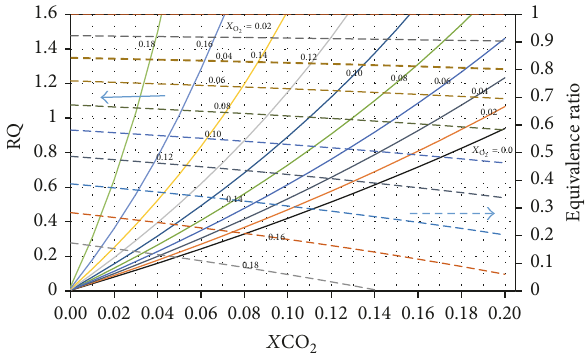
Figure 6: Variation of RQ and equivalence ratio { called OEF in biology } with respect to dry carbon dioxide with oxygen mole fraction in the flue gas as parameter (see the Appendix for relations). Solid lines: RQ with 𝑋 as parameter; O 2 dashed lines: ER with 𝑋 as parameter. As CO 2 % in exhaust O 2 increases, it implies increasing RQ for given O 2 %. At given CO 2 %, increase in O 2 % in exhaust implies increasing